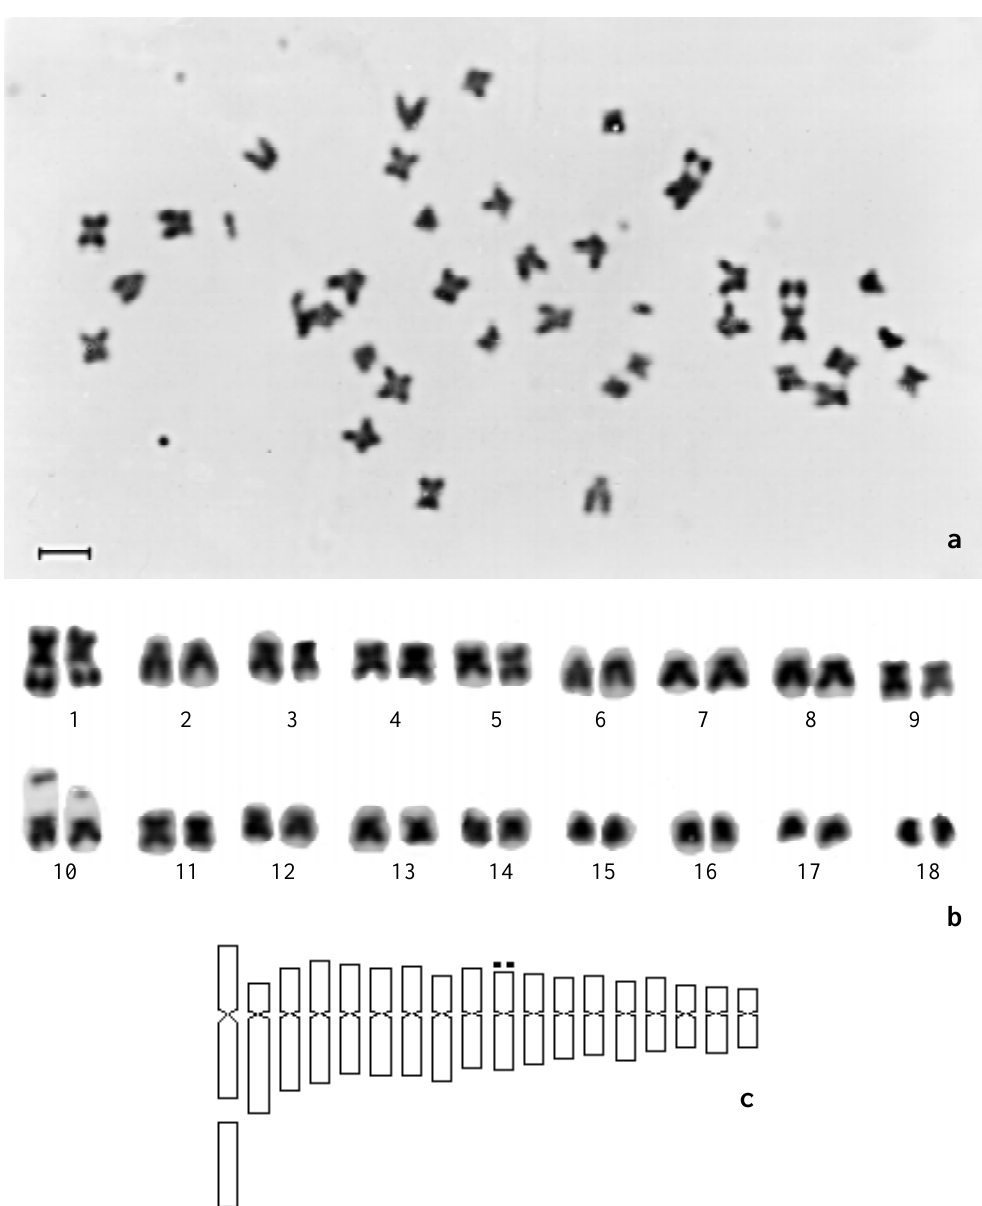
Figure 1 - a, Metaphase cell with 2n = 36 chromosomes; b, karyotype; c, idiogram of Mikania cordifolia . Bar represents 2 m